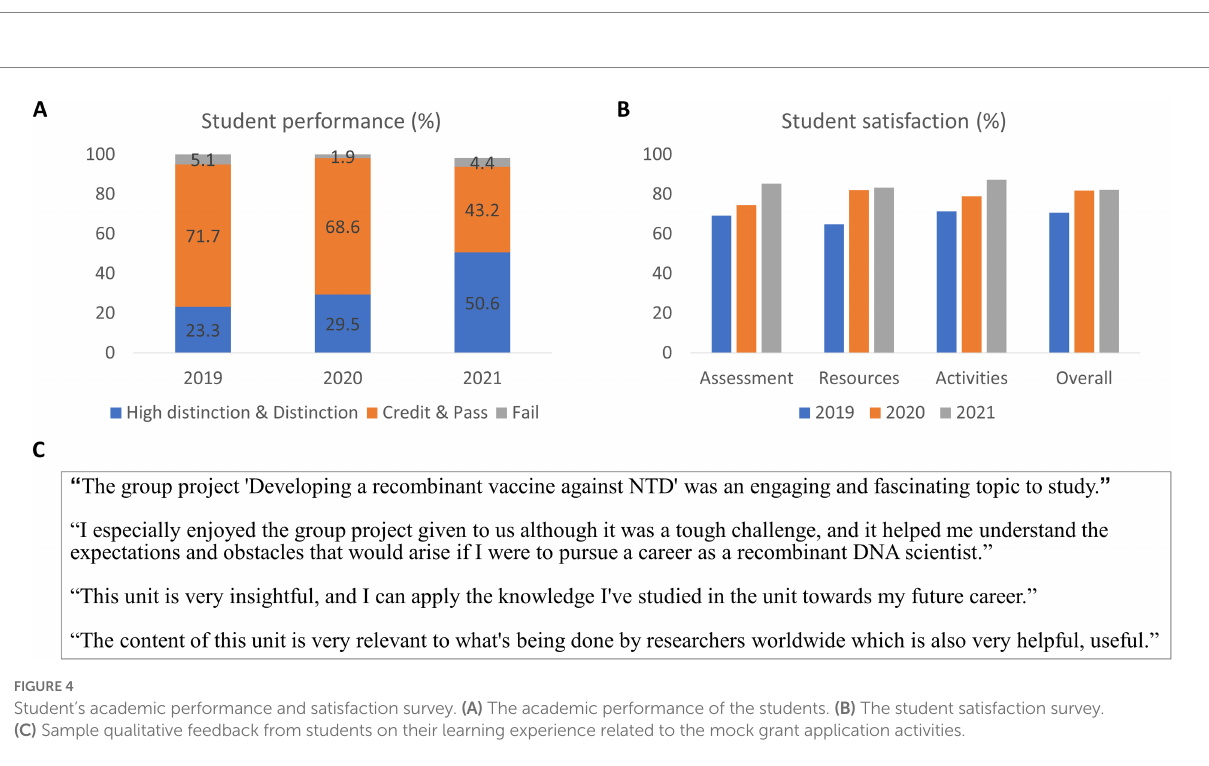
FIGURE 4 Student’s academic performance and satisfaction survey. (A) The academic performance of the students. (B) The student satisfaction survey. (C) Sample qualitative feedback from students on their learning experience related to the mock grant application